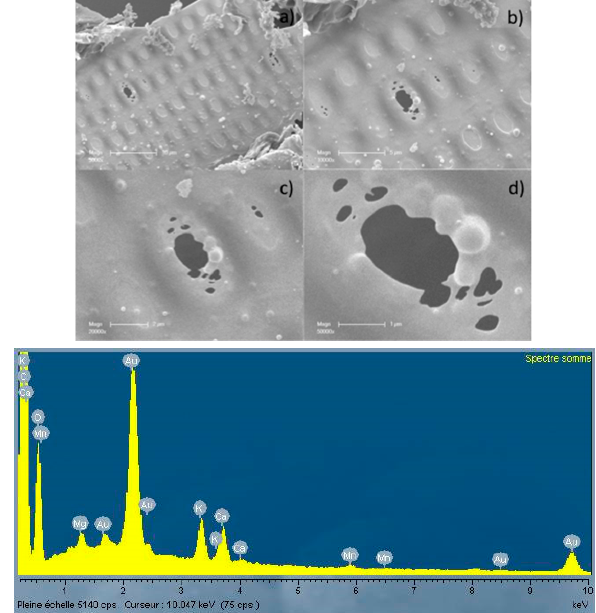
Figure 4. SEM photographs and X-ray fluorescence analysis of the surface of the biochar produced after pyrolysis of wood particles at 600 °C and different enlargements ( a ) ×5000; ( b ) ×10,000; ( c ) ×20,000; and ( d ) ×50,000.